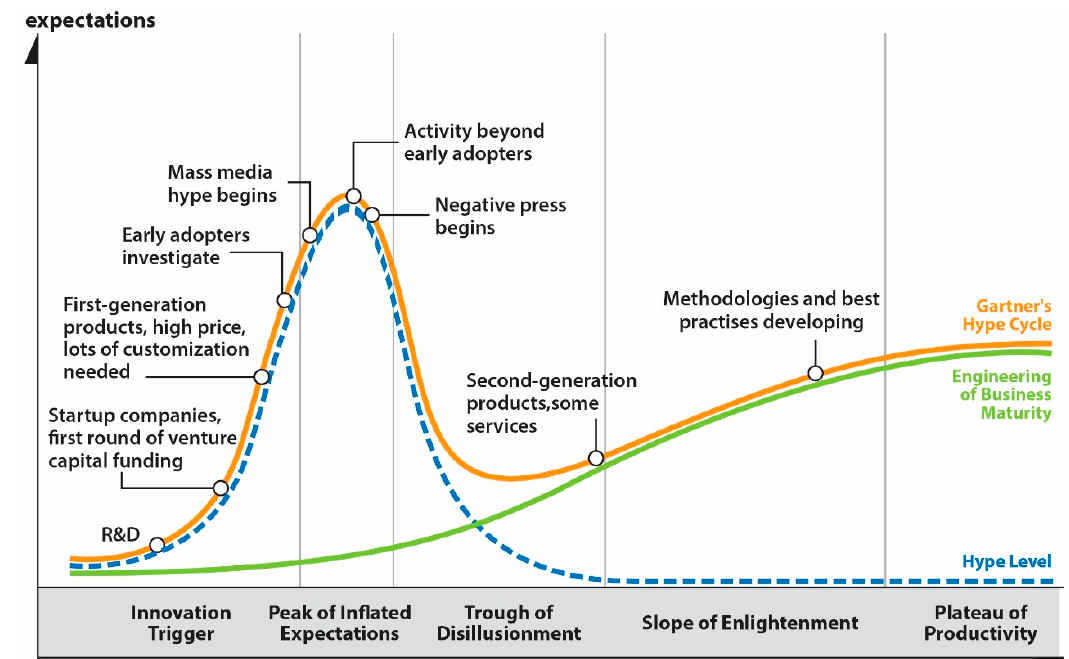
Figure 1. Gartner’s Hype Cycle curve and the two curves it combines: Hype Level curve and Engineering of Business Maturity Technology S-Curve (adopted from [18]).